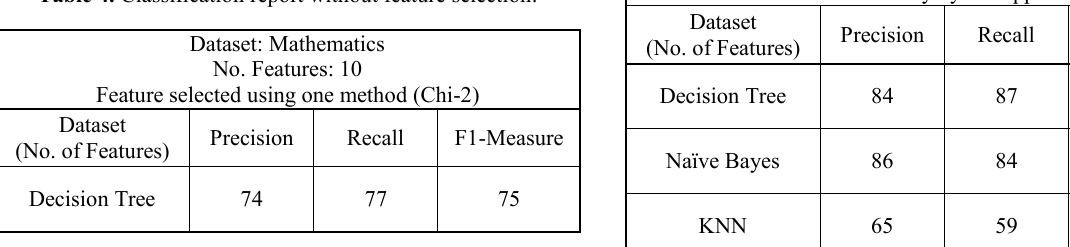
Table 4. Classification report without feature selection.